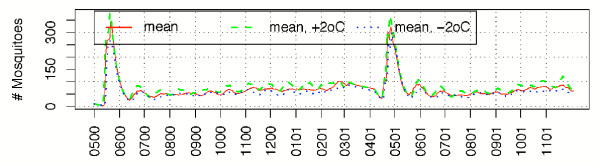
An. gambiae adult abundance, mean of 20 simulations for each temperature level